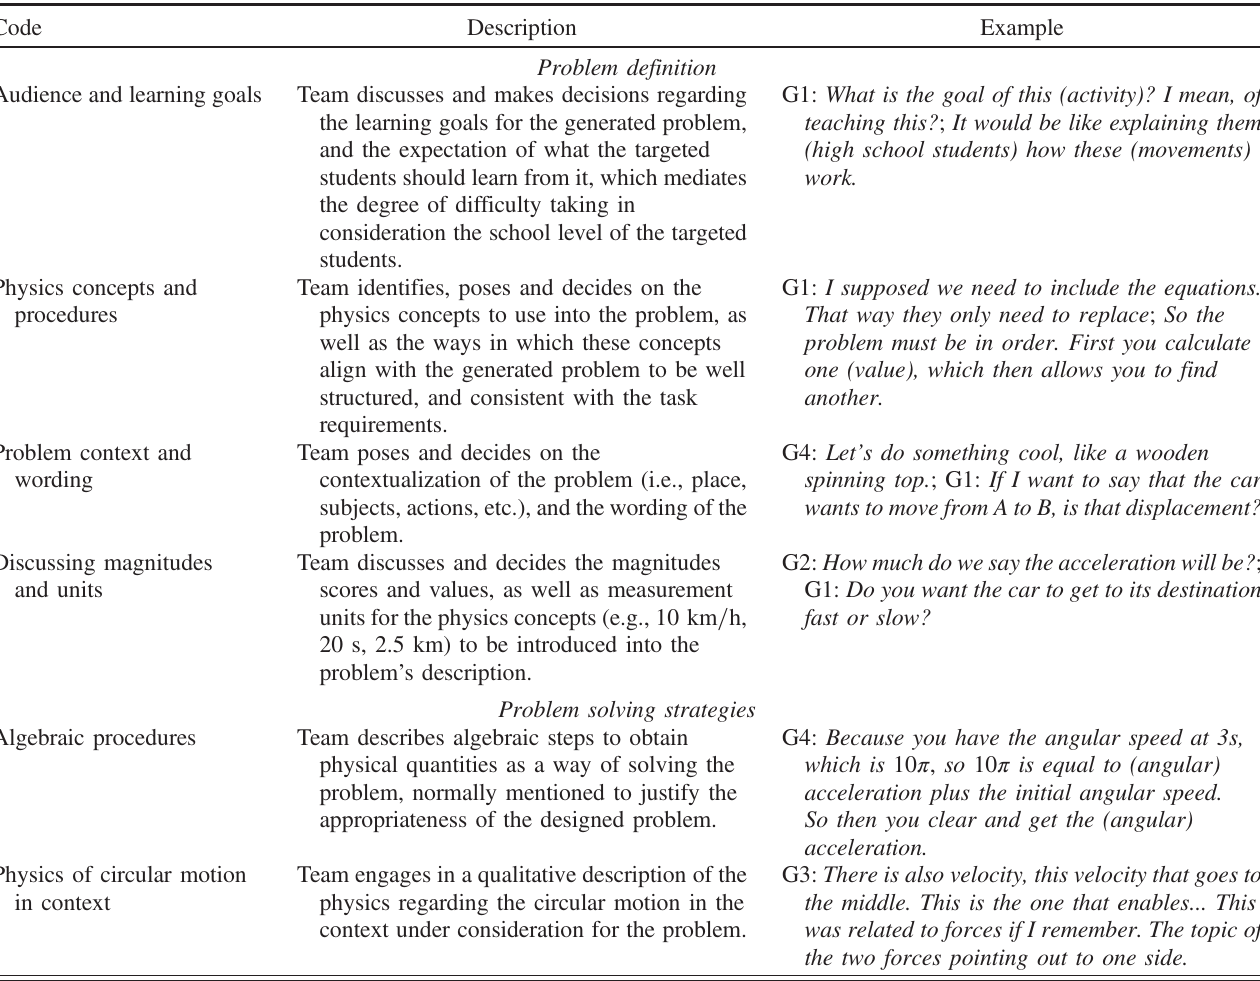
TABLE I. Code book of emergent categories and themes addressed by 4 participant groups during the task of composing a physics